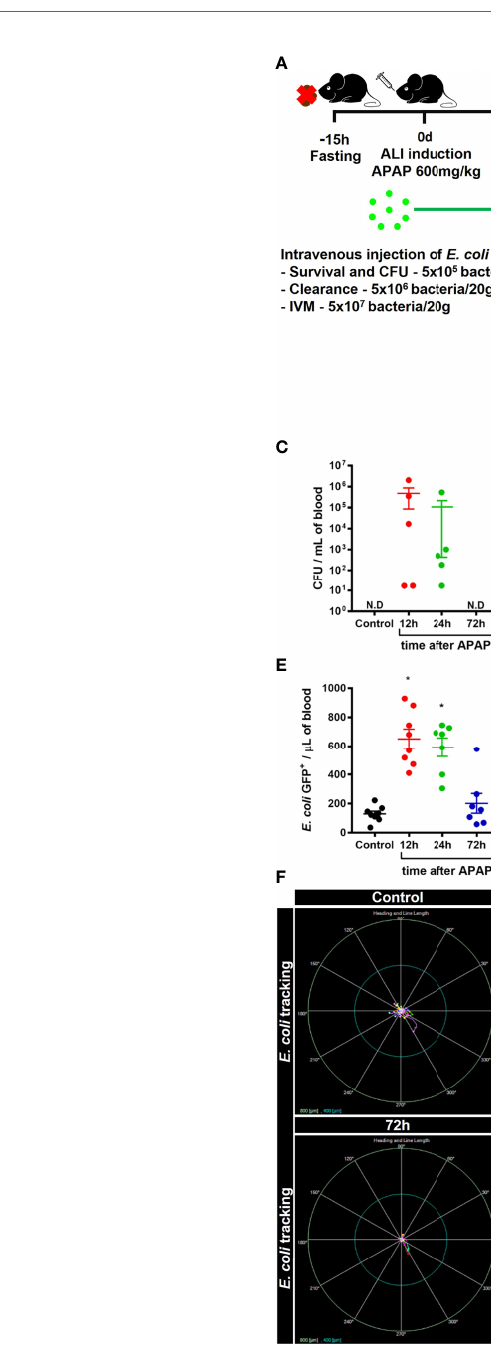
FIGURE 5 | ALI impairs liver fi rewall function and promotes susceptibility to bacterial infection. (A) Scheme for intravenous (i.v) injection of E. coli bacteria during the time-course of ALI on 8-10 weeks old C57BL/6J mice. (B) Mice survival rate (%) after infection with 5x10 5 bacteria/20g in APAP untreated control mice or in mice 24h after APAP overdose (APAP 24h group); n ≥ 5 mice per group. Quanti fi cation of Colony-forming units (CFU) of E. coli in the blood (C) and liver (D) 24h after infection with 5x10 5 bacteria/20g; n ≥ 9 mice per group; Representative of 3 independent experiments. (E) Measurement of liver fi rewall function by quanti fi cation of GFP + bacterial events from blood samples (Left panel) by Flow cytometry and determination of the blood clearance ability (Right panel; Increase over the control ( —————— = 1) 5 minutes after infection with 5x10 6 bacteria/20g; n ≥ 3 mice per group; Representative of 3 independent experiments. (F) In vivo real-time tracking of E. coli by Intravital Microscopy (IVM) during the fi rst 5 minutes after infection with 5x10 7 bacteria/20g; Representative bacterial displacement graphs for each group; scale = 800 µm; n ≥ 5 mice per group. Representative of 2 independent experiments. Data are presented as mean ± SEM. * indicates statistical difference compared to the control group using Mantel-Cox for survival test (B) , non-parametric Kruskal Wallis test followed by Dunn's multiple comparisons tests (C, D) , and one-way ANOVA followed and Tukey post-test (E) (* = p <